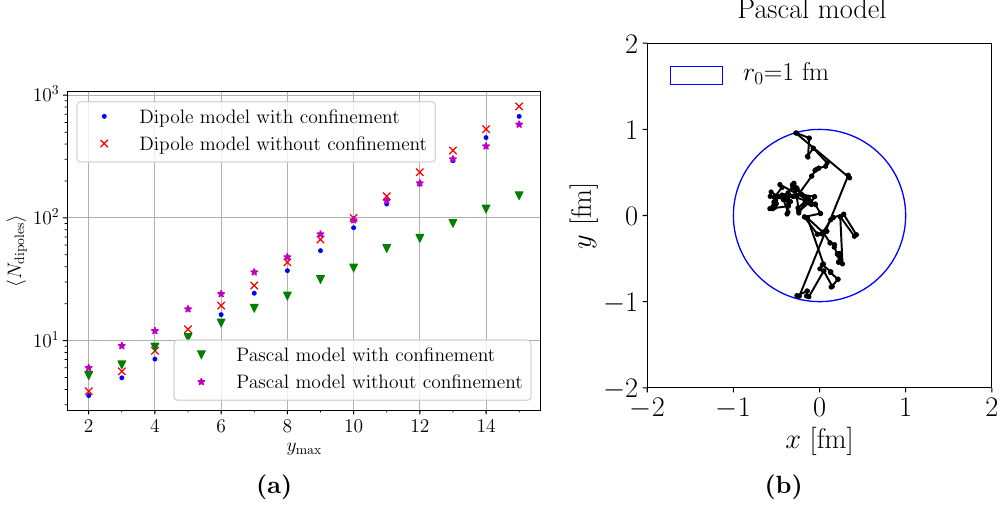
Figure 6. (a) The average number of dipoles inside a proton after a full evolution to maximal rapid- ity y . (b) An initial state proton consisting of three dipoles in an equilateral triangle con(cid:12)guration after a full evolution with the Pascal model at 7 TeV (corresponding to y max = 8 :